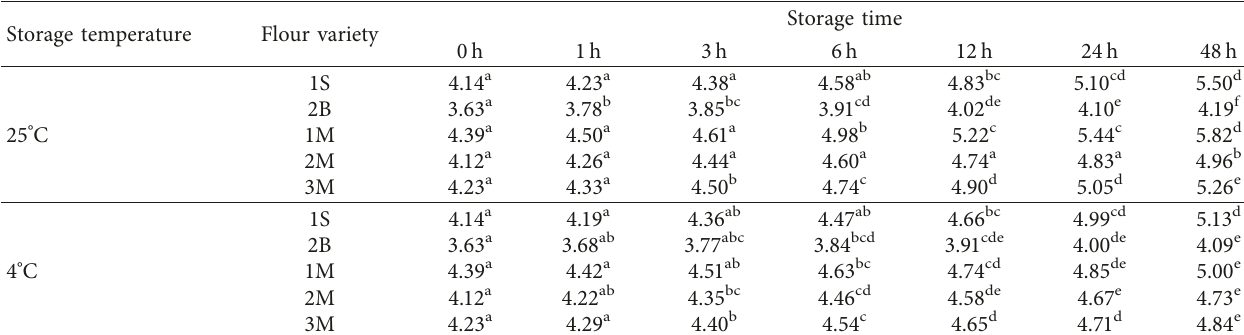
Table 4: Cooking loss rate of fresh wet noodles made from different flours during storage.